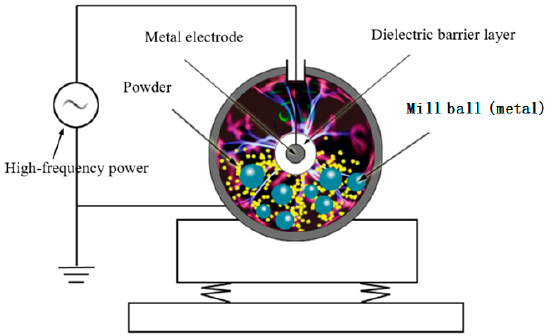
Figure 1. Schematic design of dielectric barrier discharge plasma-assisted ball milling.